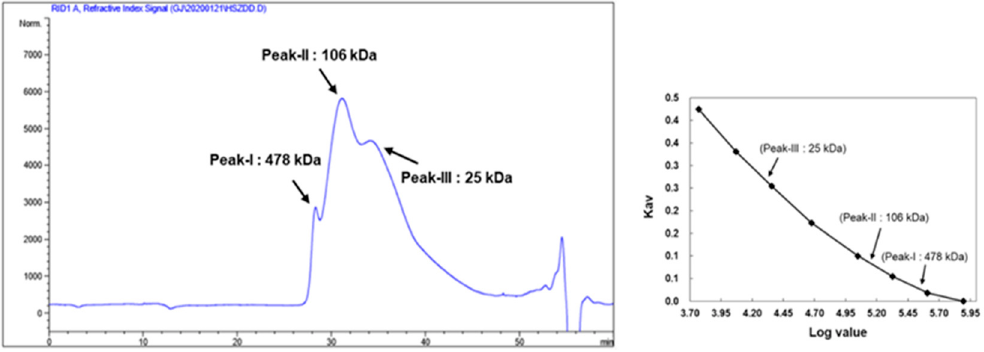
Figure 1. Molecular weight of KRG-P determined by high-performance size-exclusion chromatography, using Asahipak GS series GS-520 + GS530 + GS220 linked columns.